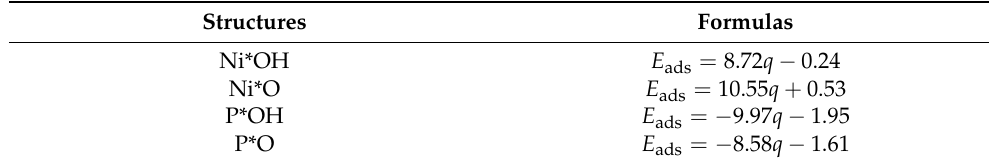
Table 2. Formulas corresponding to different structures.